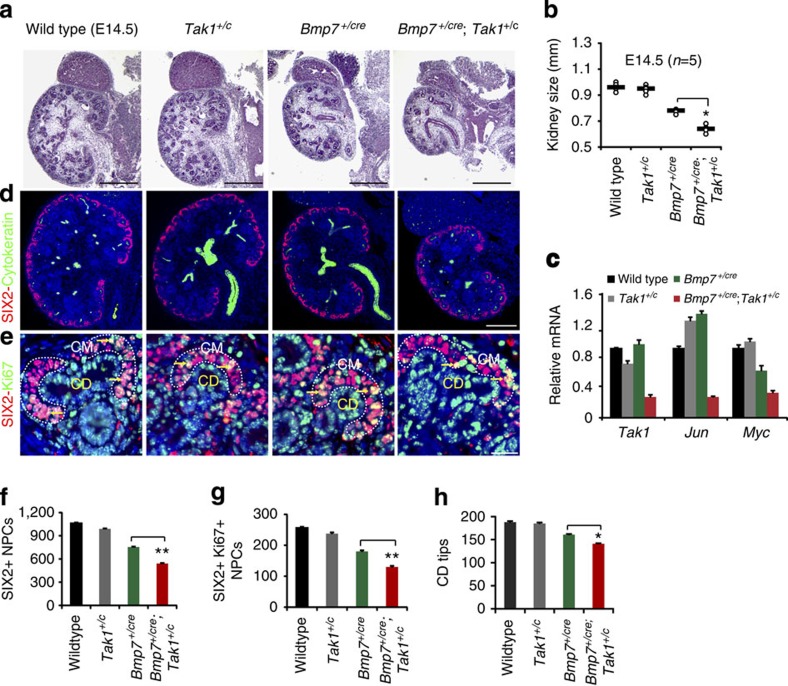
Bmp7 and Tak1 operate in the same pathway to regulate NPC renewal.(a) H&E staining of E14.5 WT, Tak1+/c, Bmp7+/cre and Bmp7+/cre;Tak1+/c kidneys. Scale bars, 500 μM. (b) Kidney sizes. Number of mice analysed per genotype is noted in the graph. *P<0.01, Student's t-test. (c) RT–qPCR of NPCs from P0 kidneys for Tak1, Jun and Myc in mutants and WT control. Error bars represent s.d. Two biological replicates analysed per genotype, n=2. (d) SIX2 (red, cap mesenchyme) and cytokeratin8 (green, collecting duct) immunostaining of whole kidney sections. Scale bars, 500 μM. (e) Co-immunostaining of SIX2 and the proliferation marker Ki67. Scale bars, 50 μM. (f–h) Quantitation of SIX2+, SIX2+/Ki67+, and collecting duct tips from 5 to 10 serial sections per kidney per genotype. Arrows point to Ki67+/SIX2+ cells in the cap mesenchyme, which is highlighted by white dashed lines. Error bars represent s.d. **P<0.005 and *P<0.05, Student's t-test. CD, collecting duct; CM, cap mesenchyme.